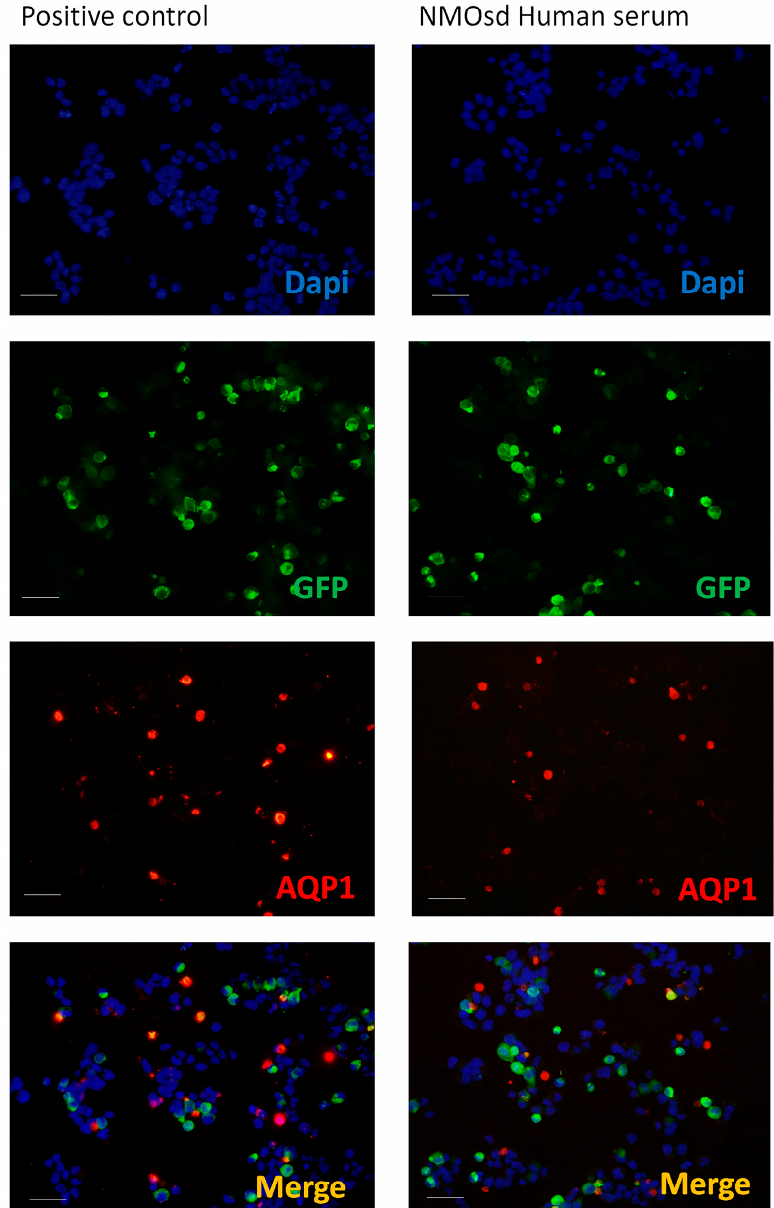
Figure 3. Immunofluorescence assay for the detection of anti-AQP1 antibodies. Representative images of the immunofluorescence assay developed in our laboratory using cells expressing human aquaporin-1 (AQP1) (hAQP1-EGFP) fused to GFP (green). The immune reaction produced by anti-AQP1 antibody (ab15080, ABCAM) (left panels) and by patient serums from Neuromyelitis optica spectrum disorder ( + NMOsd) (right panels) over AQP1 expressing cells (red). Nuclei were visualized with Dapi (blue) and the merged image of both fluorescent signals (anti-AQP1 antibodies and GFP) is shown in yellow. Scale bar 100 µm.